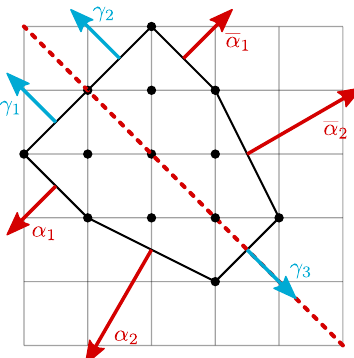
Figure 13. A generic toric diagram with a diagonal axis